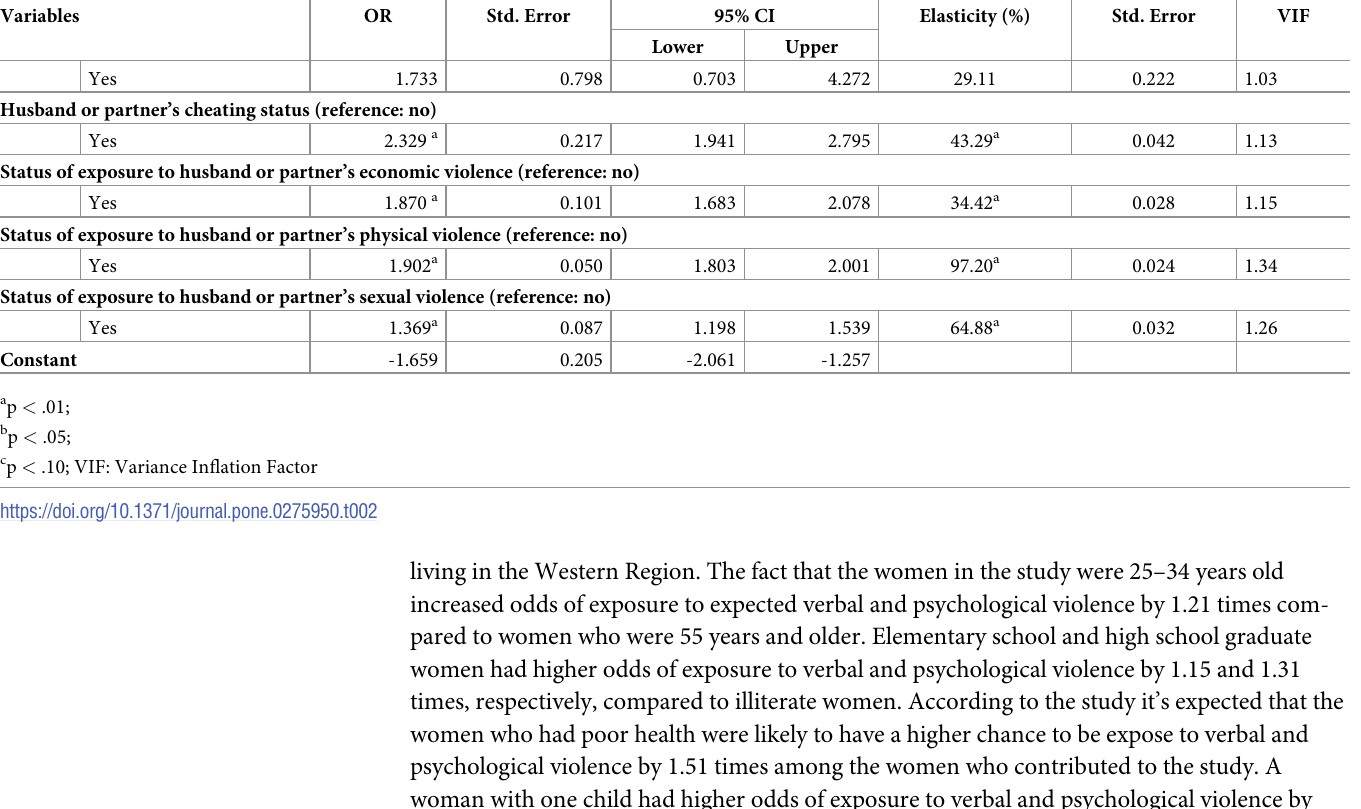
logical violence by 1.79 times compared to